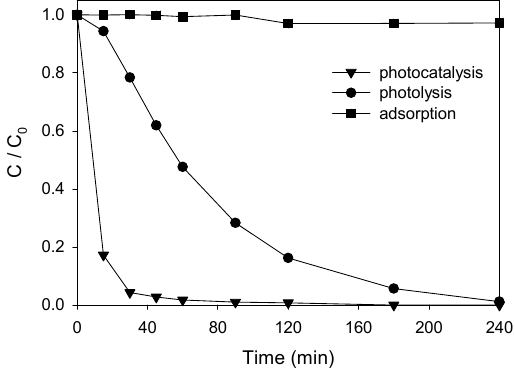
Figure 7. Comparison of ATL degradation methods.